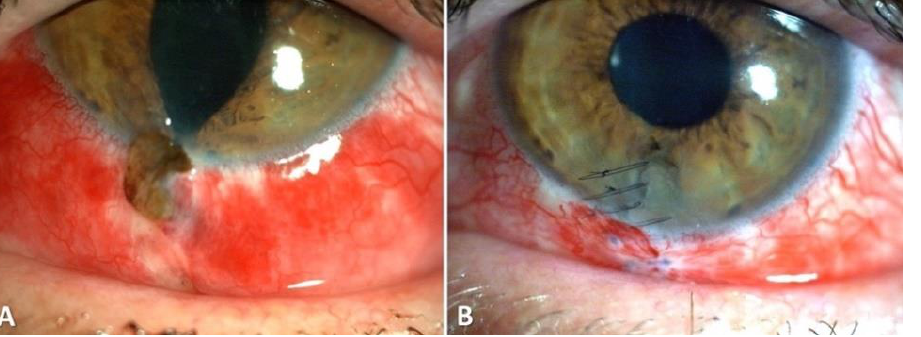
Figure 2. Example of a zone II open globe injury: Corneal dehiscence caused by a broken goggle with a consecutive iris prolapse. Setting before surgery ( A ) and after iris reposition and wound closure ( B ).